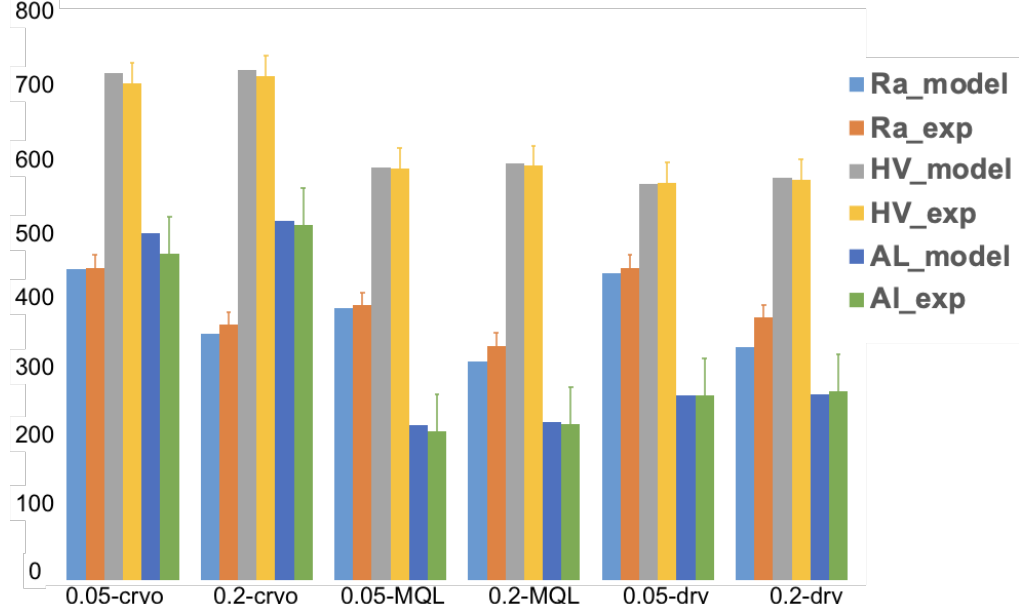
Figure 12. Validation data for numerical vs. experimental results: DoB (mm) on x axis; Ra (µm × 10 3 ), HV 0.1 , AL (µm).